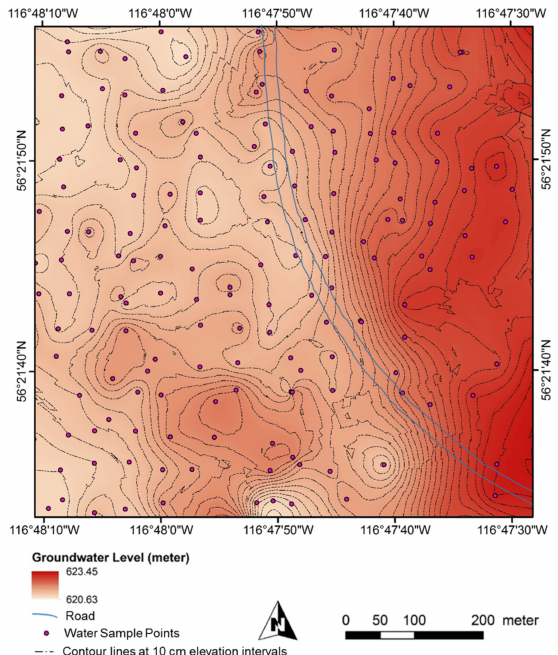
Figure 5. Predicted ground-water level across the study area.